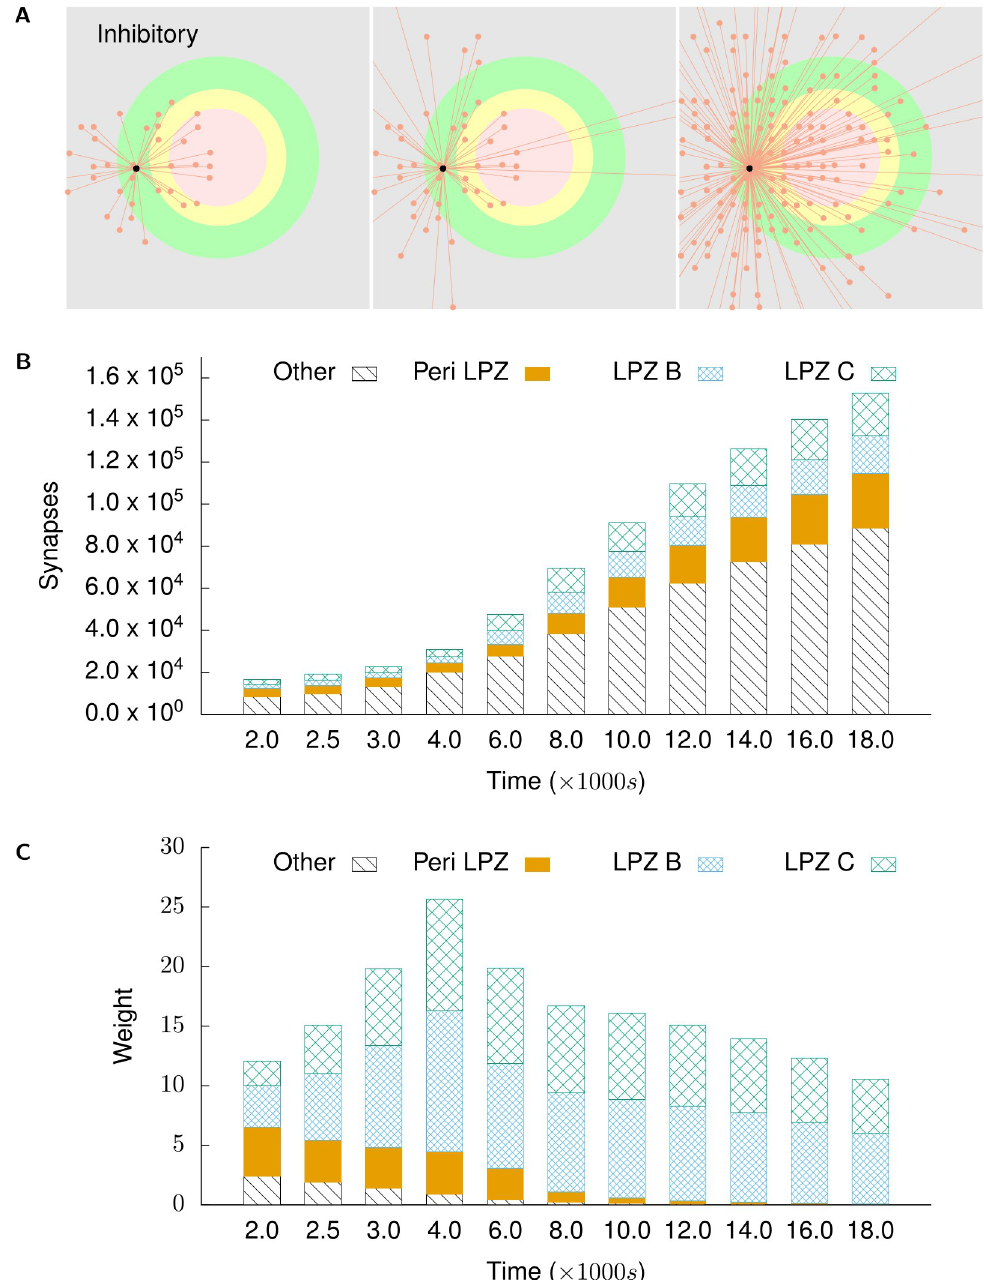
Fig 9. Inhibitory projections to excitatory neurons in the peri-LPZ. (A) shows incoming inhibitory projections to a randomly chosen neuron in the peri-LPZ at different stages of our simulations. From left to right: t = 2000 s, t = 4000 s, and t = 18,000 s. (B) shows the total numbers of incoming excitatory projections to neurons in the peri-LPZ from different regions at different points in time. (C) shows the mean weight of projections received by neurons in the peri-LPZ from different regions at different points in time. In contrast to neurons in the LPZ, neurons outside the LPZ experience an increase in activity in our simulations. As a result of our growth rules, these neurons gain inhibitory inputs.